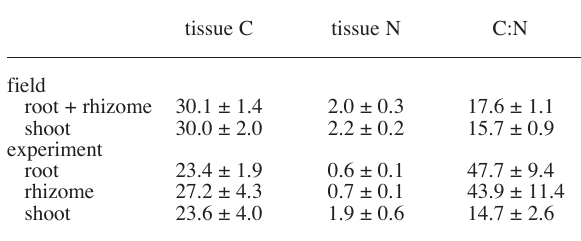
T ABLE 2. – Tissue C and N contents (% DW) and atomic ratio in Cymodocea nodosa plants collected from the field and after four months of dark incubation. Data are given as means (n=4, ± SD).